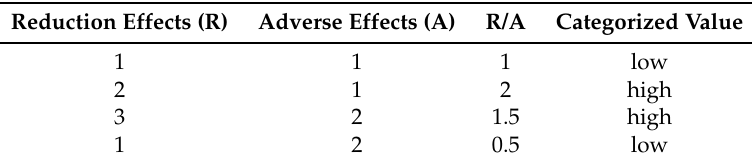
Table 2. Example of the class attribute categorization.